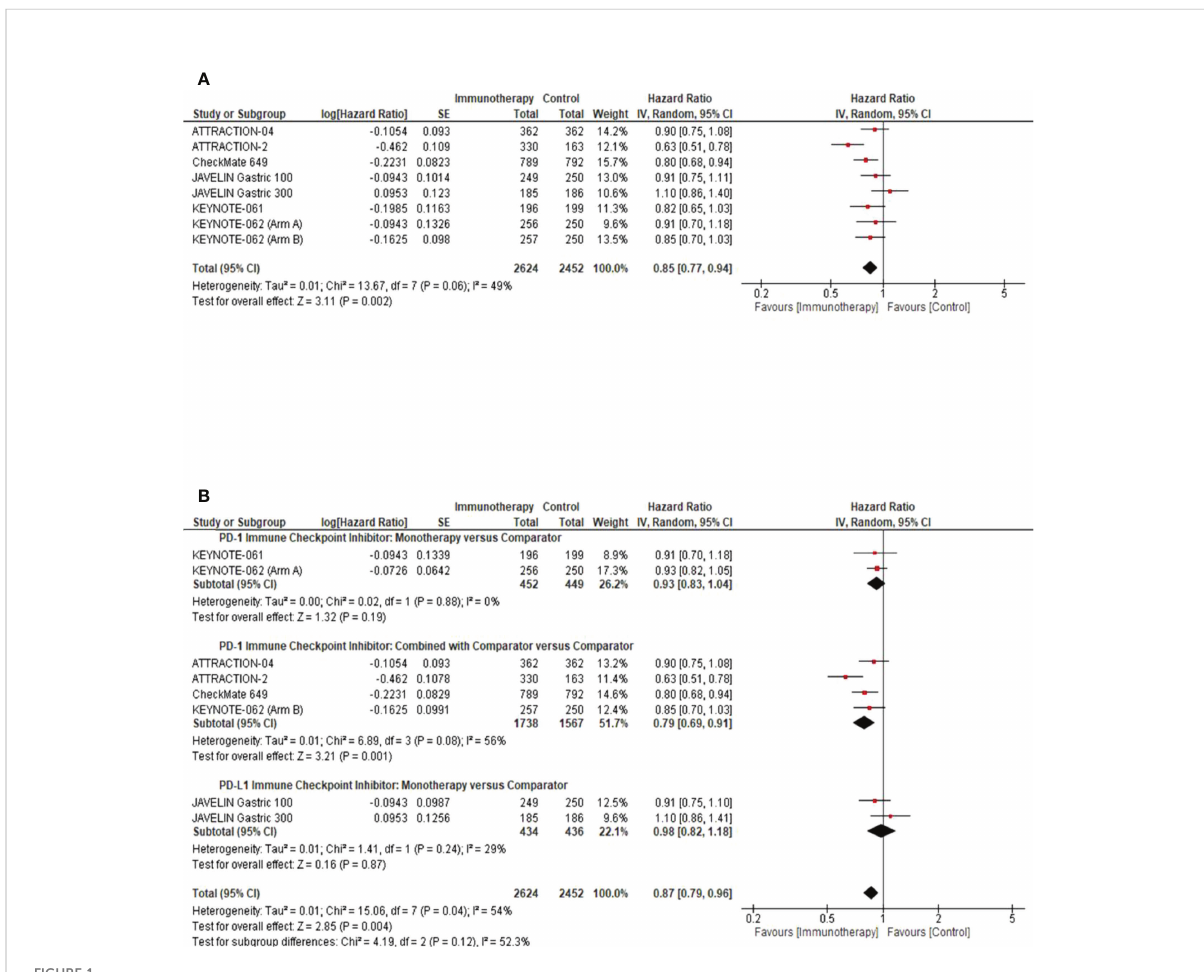
combination with the comparator arm, on the median OS of the intention to treat population. Comparator arm: the active treatment in the control arm as de fi ned by the study methods. CI, con fi dence interval; SE, standard